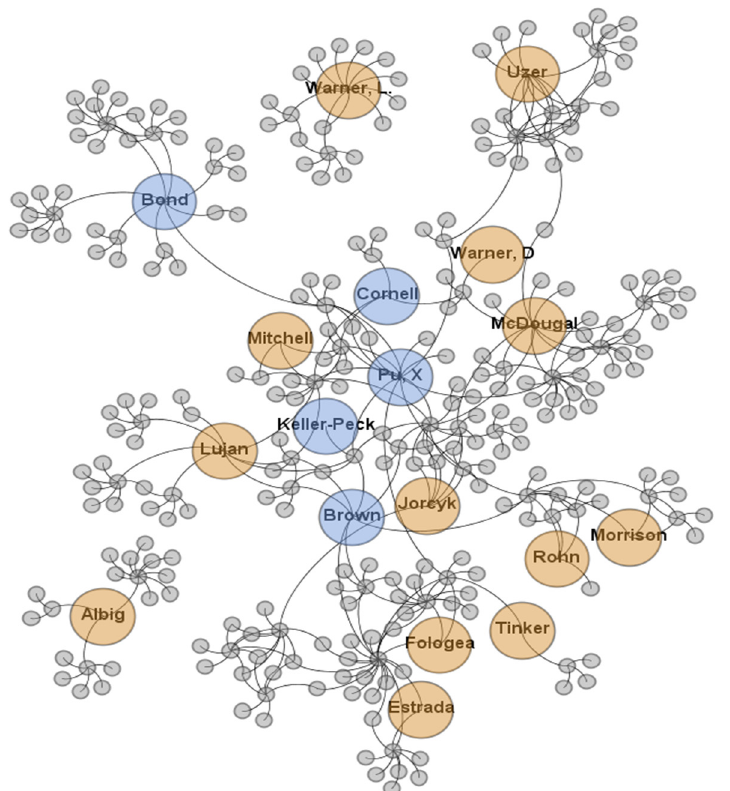
Figure 1. Co-authorship within the Center. This visual interpretation of the Center highlights 13 junior investigators (orange) and Biomolecular Research Core research scientists (blue) among 303 total authors affiliated with the Centers of Biomedical Research Excellence (COBRE) in Matrix Biology by citing the grant in their publications. Each node represents an individual author and edges (connections) represent co-authorship. Nodes repel each other like charged particles, while edges attract their nodes, like springs, creating a movement that converges to a balanced state. The final configuration provides a visual representation that shows that Core scientists localize centrally with a high indegree (edges between nodes) and connectedness. Nodes with high outdegree are located more peripherally. Source of bibliographic data: National Institutes of Health (NIH) reporter retrieved June 2018. The network was generated using Gephi visualization software [1–4].